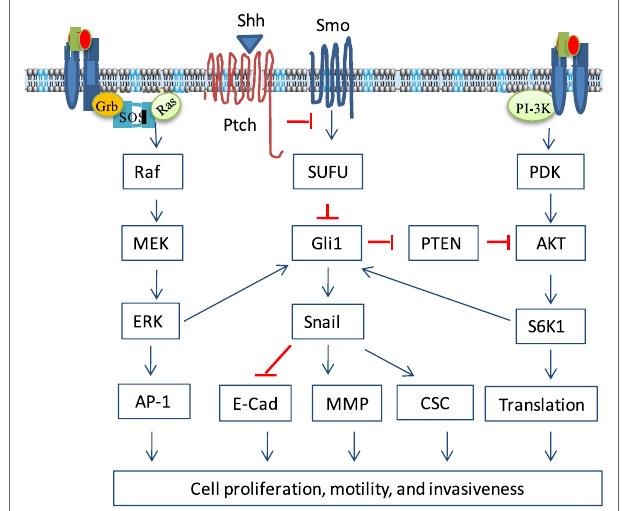
FiGURe 2 | Non-canonical activation of the sonic hedgehog (Shh) pathway. Growth factor binding to their receptors activates two prominent oncogenic pathways, the phosphortidylinositol-3 kinase (PI3K) and mitogen-activated protein kinase (MAPK) pathways. In addition to the canonical activation, Gli1 can be activated by S6 kinase 1 (S6K1)-mediated phosphorylation at Serine 84, leading to nuclear translocation and induction of gene transcription. Gli1 can also be activated by ERK, probably through phosphorylation of its N-terminus by ERK2. Gli2 activity can be regulated by the MAPK pathway through increasing its stability. In addition, the MAPK pathway can activate the Shh pathway by inducing Shh expression through transcriptional upregulation. Gli1 can reciprocally activate the PI3K pathway indirectly by inducing Bmi1 expression, which represses PTEN expression. Crosstalk between the Shh and other oncogenic pathways regulates a variety of cellular functions, including cell proliferation, cell cycle progress, epithelial-to- mesenchymal transition, cell motility and invasiveness, and cancer stem cell (CSC)